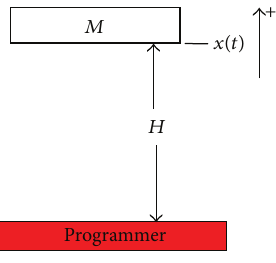
Figure 3: Model of shock